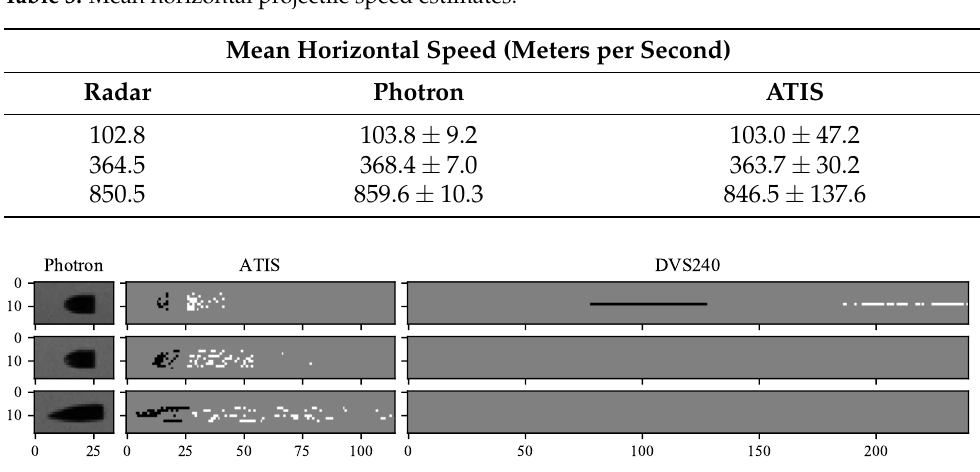
Table 3. Mean horizontal projectile speed estimates.